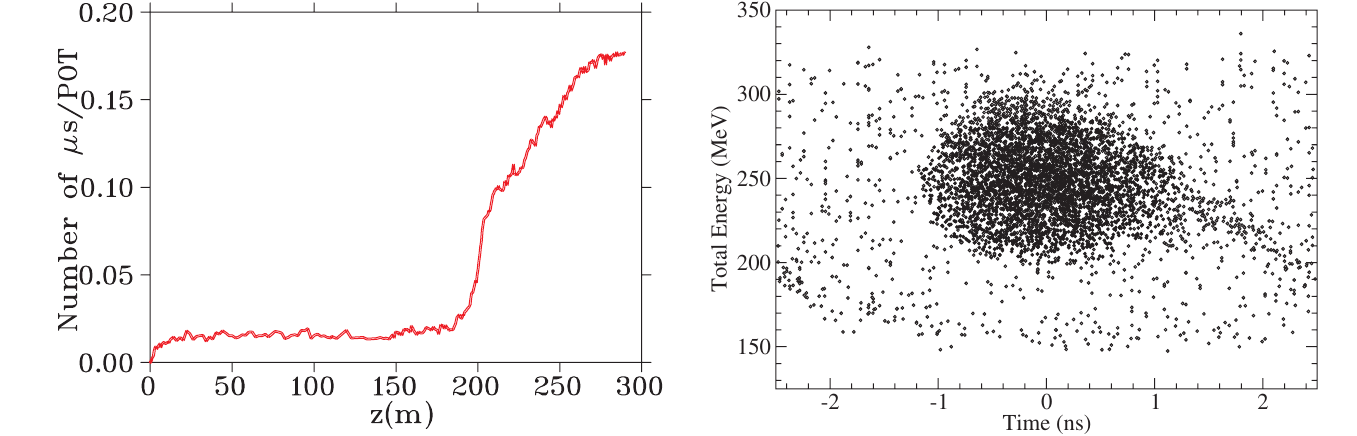
FIG. 17. Longitudinal phase space of overlayed bunches in (cid:6) the train at the end of the cooling section. The open circles are T (cid:6) all the particles that reach the end of the channel and the filled L circles are particles within the accelerator normalized transverse (cid:6) 30 mm rad and normalized longitudinal acceptance of A T (cid:6) 150 mm for a momentum cut 0 : 1 (cid:10) p (cid:10) acceptance of A L 0 : 3 GeV =c .